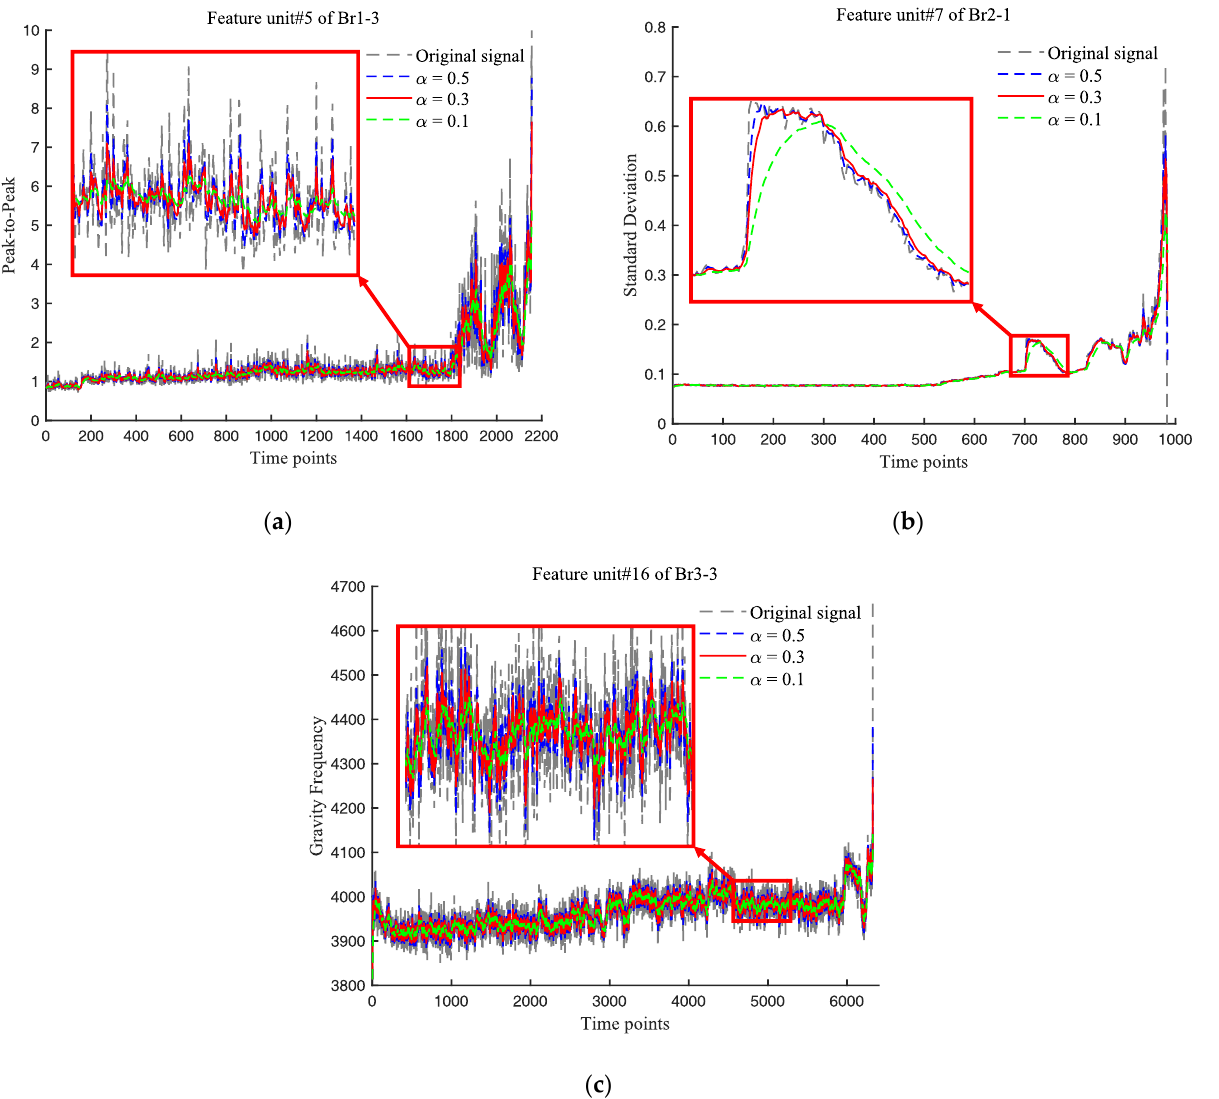
Figure 9. ( a ) Performance of ES on peak-to-peak of Br1-3; ( b ) performance of ES on standard deviation of Br2-1; ( c ) performance of ES on gravity frequency of Br3-3.